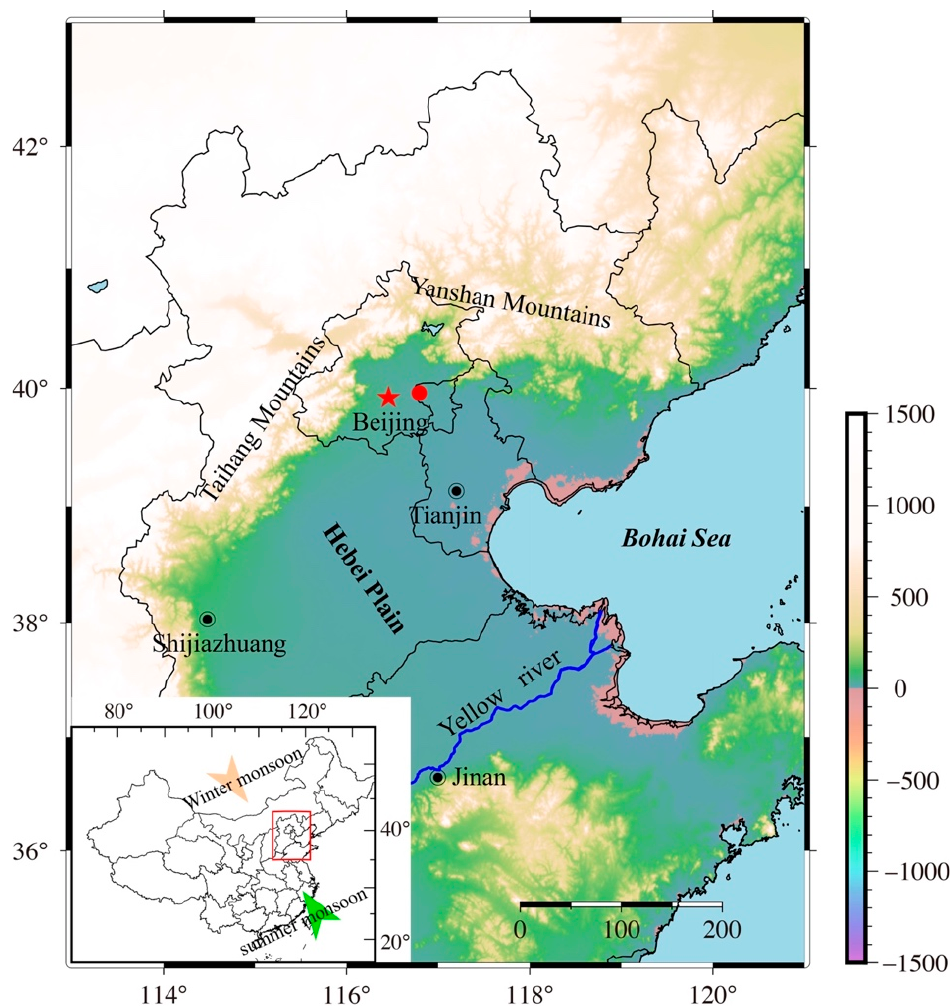
Figure 1. Map showing the location of Hebei plain and the SHBZK-1 core (the red dot).